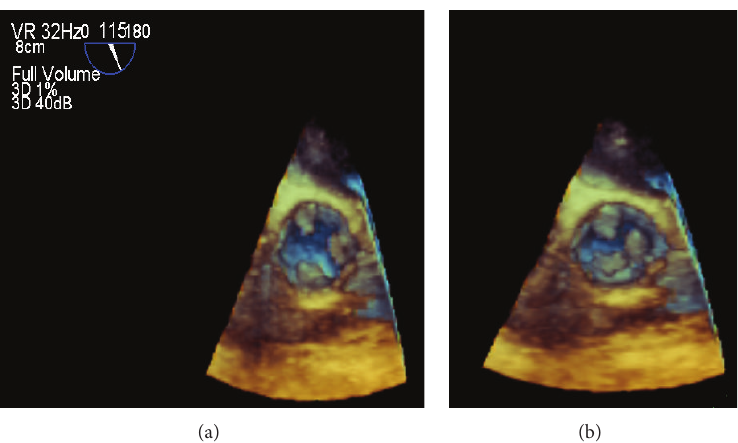
Figure 2: 3D midesophageal aortic valve short-axis view. In (a), the valve is opening. Note the vegetation on all three leaflets. In (b), the valve is closed and vegetation can be seen obstructing the point of coaptation.